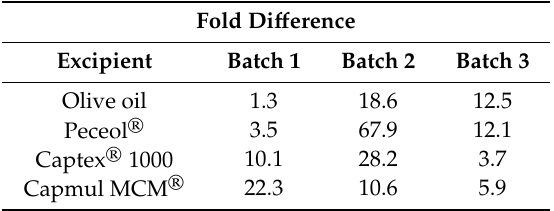
Table 5. Fold di ff erence between the supersaturated venetoclax concentrations reached at 70 ◦ C and the measured solubility for olive oil, Peceol ® , Captex ® 1000 and Capmul MCM ® , where n = 1 for initial